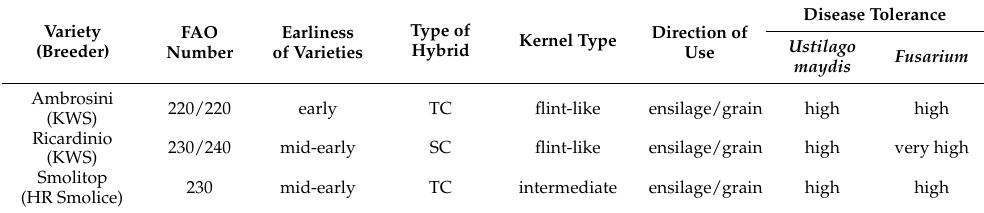
Table 1. Comparison of maize varieties used in the experiment. Variety FAO Earliness (Breeder) Number of